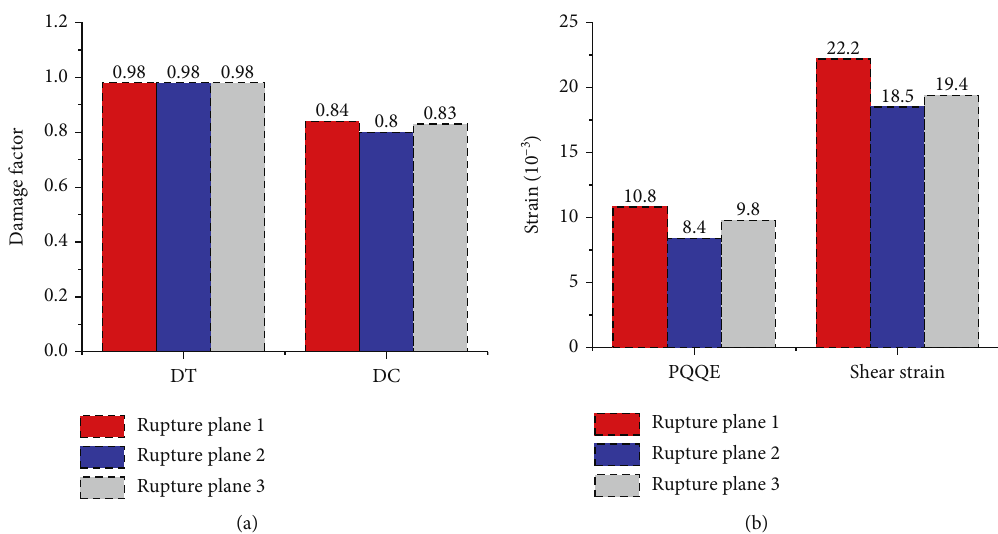
Figure 5: Maximum damage index of di ff erent rupture plane. (a) Tensile and compressive damage. (b) PQQE and shear strain.